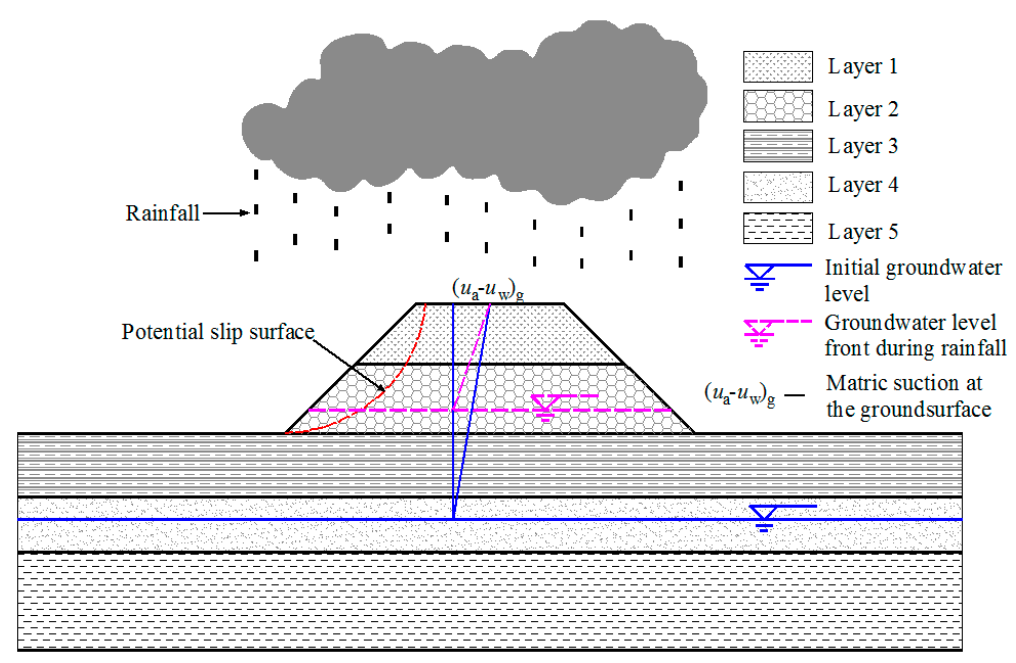
Figure1. Crosssectionofunsaturatedmultilayeredcoastal-embankmentslopeunderrainfallinfiltration. J. Mar. Sci. Eng. 2019 , 7 , x FOR PEER REVIEW Figure 1. Cross section of unsaturated multilayered coastal-embankment slope under rainfall infiltration.